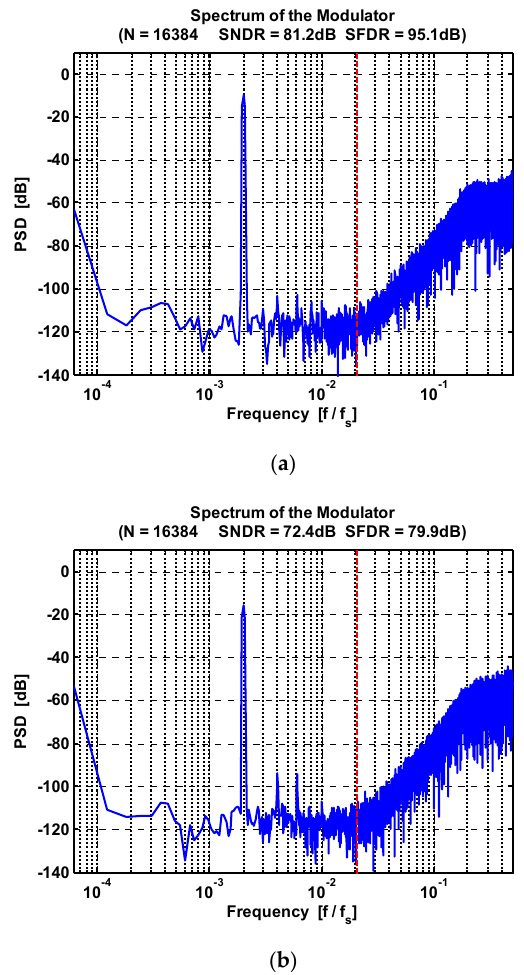
Figure 11. Die micrograph.